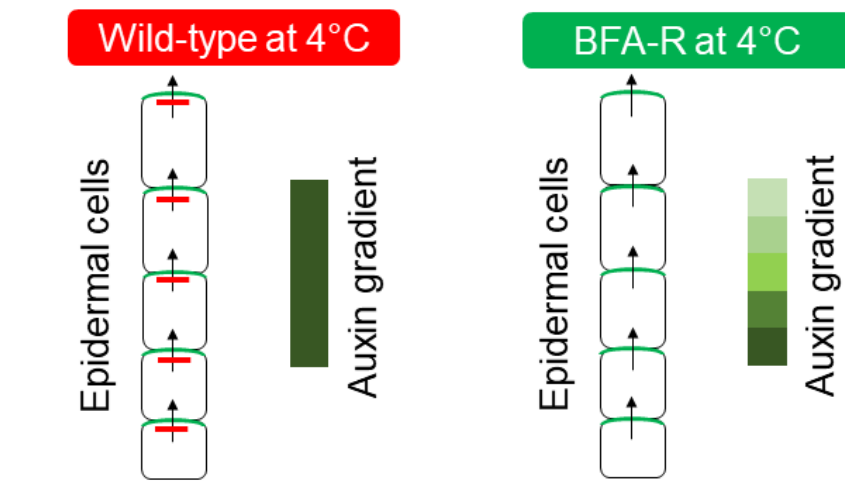
Figure 3. GNOM-mediated faster root growth recovery mechanism under cold stress. ( Left ) Balanced auxin homeostasis in the epidermal cell layers of root at 23 ◦ C. ( Middle ) Low temperature-mediated inhibition of PIN2 trafficking and altered auxin gradient in the epidermal cell layers at the root. ( Right ) GNOM-engineered BFA-resistant line helps to retain functional PIN2 trafficking under cold stress to maintain proper auxin gradient for root growth.